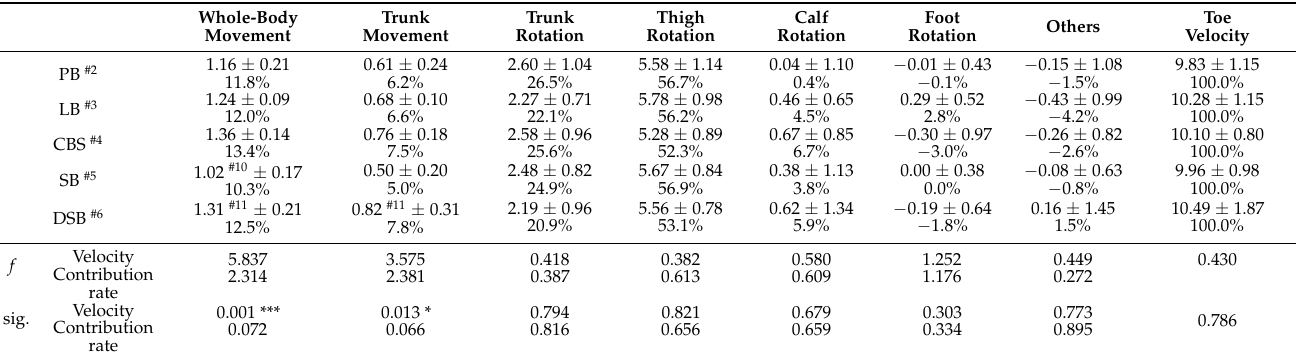
Table 2. The contributions of the roundhouse kick with distance-change types of footwork in MKF event. Units: